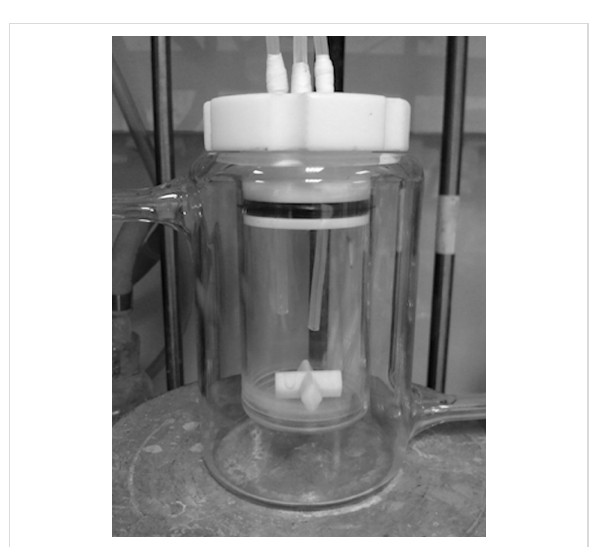
Figure 6: Interior of 50 mL